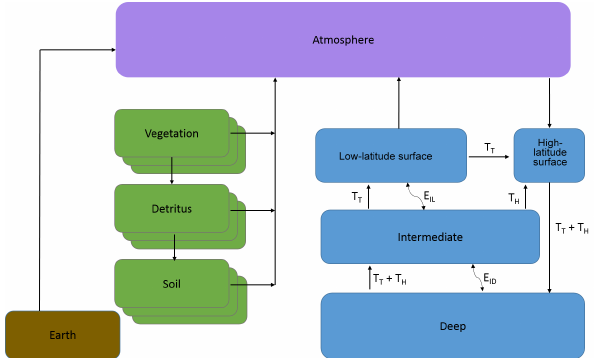
Figure 1. Representation of the carbon cycle in Hector. The atmo- sphere consists of one well-mixed box, connected to the surface ocean via air–sea fluxes of carbon. The terrestrial component con- sists of user defined biomes or regions for vegetation, detritus, and soil. The earth pool is continually debited to act as a mass-balance check on the carbon cycle (Hartin et al., 2015). The ocean con- sists of four boxes, with advection (represented by straight arrows) and water mass exchange (represented by curved arrows) simulating thermohaline circulation. The marine carbonate system is solved for in the high- and low-latitude surface boxes. At steady state, there is a flux of carbon from the atmosphere to the high-latitude surface box, while the low-latitude surface ocean releases carbon to the at- mosphere.